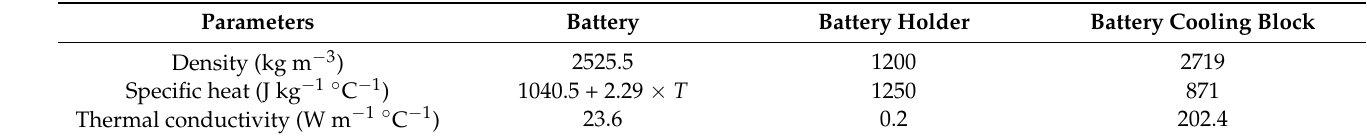
Figure 1. Modeling of the battery module according to the port number: ( a ) Port = 1; ( b ) Port = 2; ( c ) Port = 3; ( d ) Fluid volume at port 3. Table 1. Thermo-physical properties of the battery module